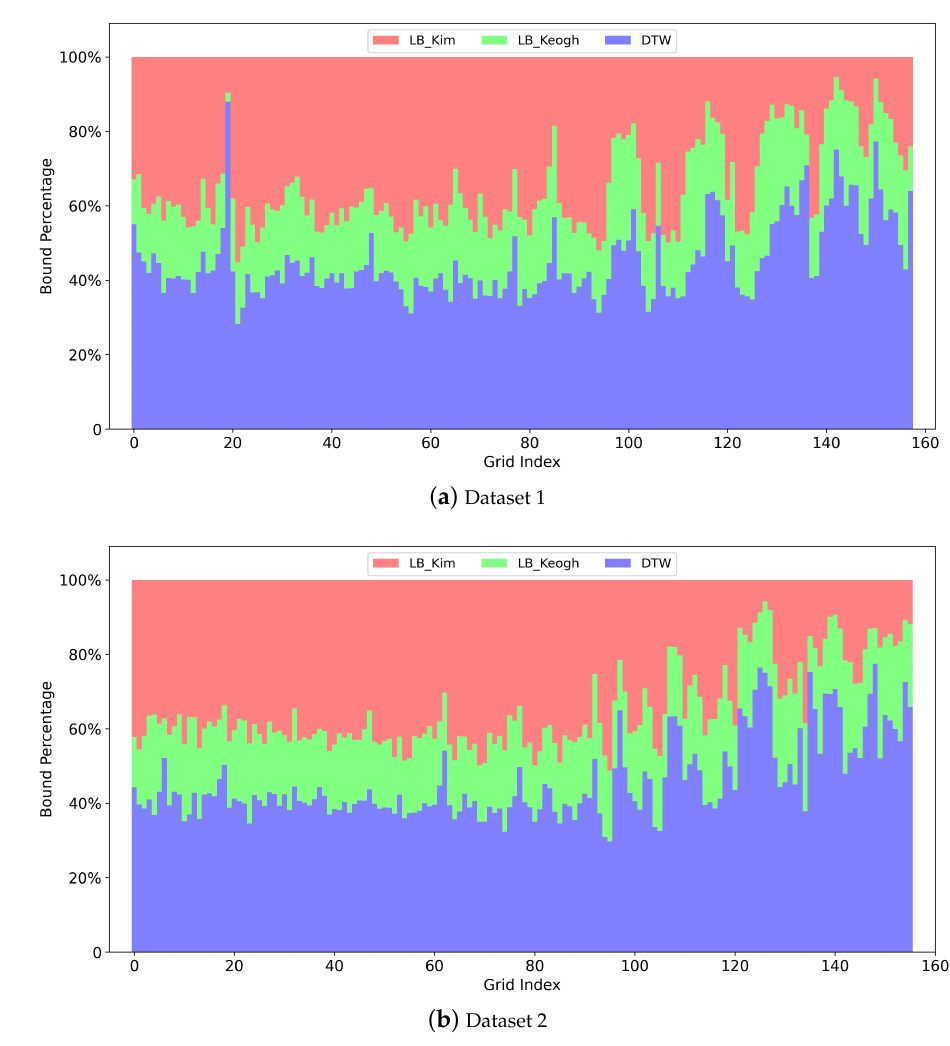
Figure 14. Percentages of candidates that are pruned by LB_Kim or LB_Keogh , or trigger the final calculation of DTW in each grid of the two SITS